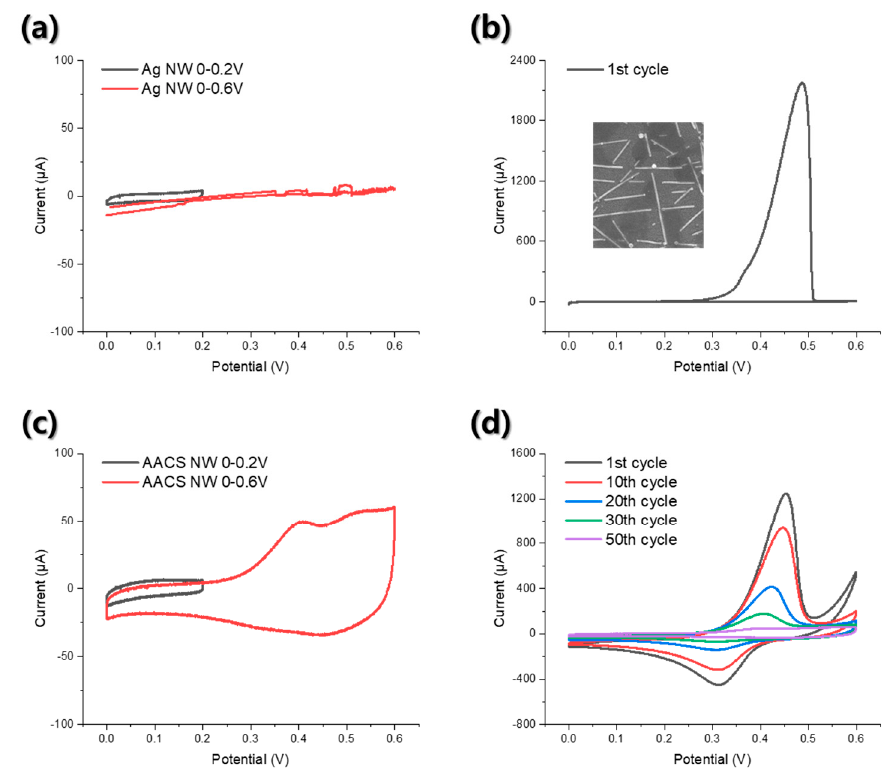
Figure 3. Electrochemical properties of the Ag NW and the AACS NW network electrode. ( a ) CV curves for the Ag NW electrode. The black line shows the CV curve in the 0 − 0.2 V scan range, and the red line shows the CV curve of the second cycle in the 0 − 0.6 V scan range. ( b ) CV curve of the first CV cycle in the 0 − 0.6 V scan range for the Ag NW electrode. The inset figure shows the SEM image of the Ag NW network after the CV cycles in the 0 − 0.6 V scan range. ( c ) CV curves for AACS NW electrode. The black line shows the CV curve in the 0 − 0.2 V scan range, and the red line shows the CV curve of the 50th CV cycle in the 0 − 0.6 V scan range. ( d ) CV curves for AACS NW electrode from the 1st to the 50th CV cycles.